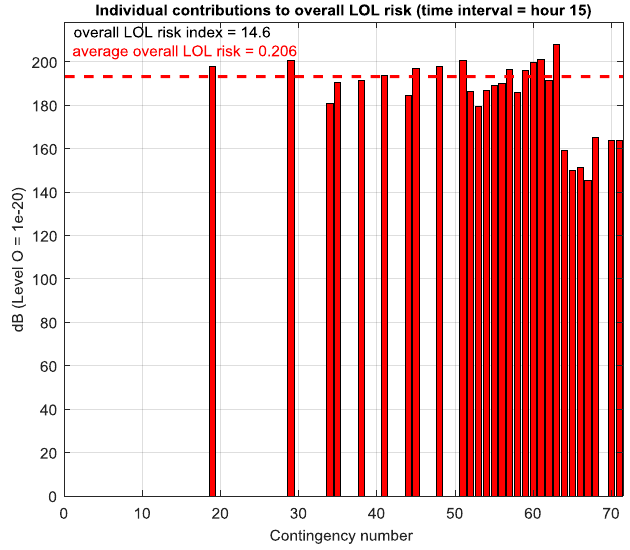
Figure 7. Histogram of loss of load risk indicators−scenario SC 1, hour 15.